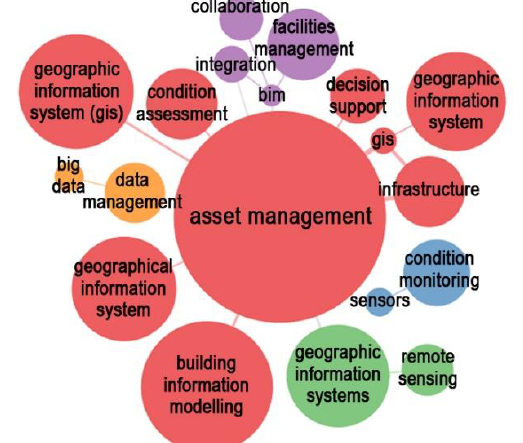
Figure 3. Keywords co-occurrence network (Scopus database)